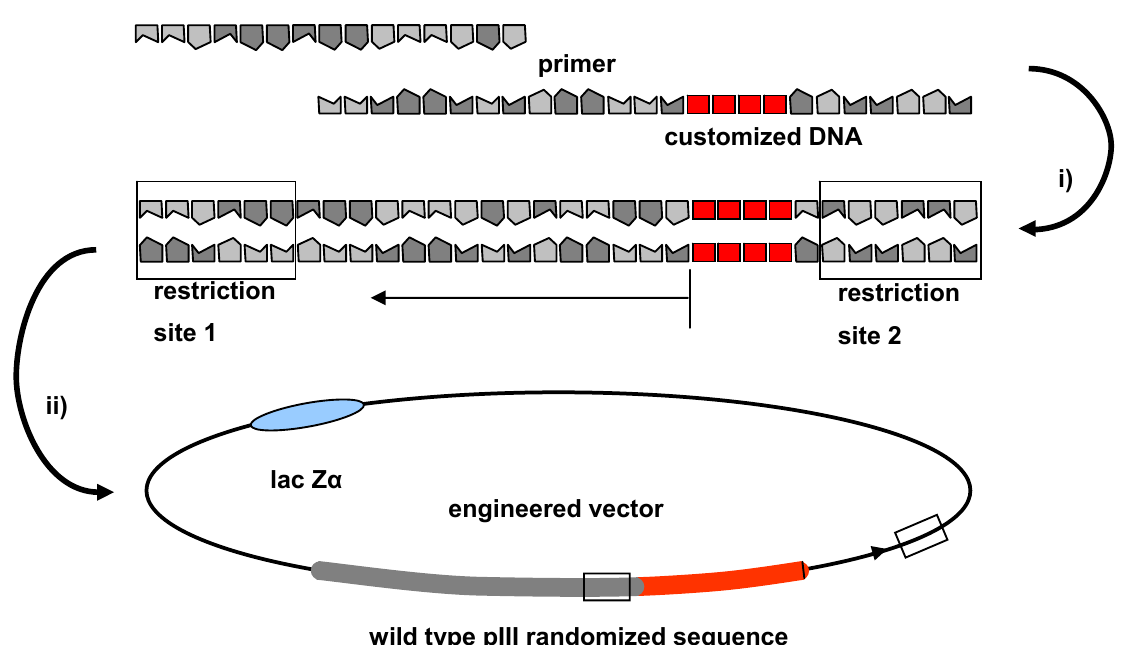
Figure 2. Schematic presentation of the introduction of foreign DNA; (i) annealing and PCR; (ii) separate double digestion, followed by DNA-ligation with an appropriate vector in digested